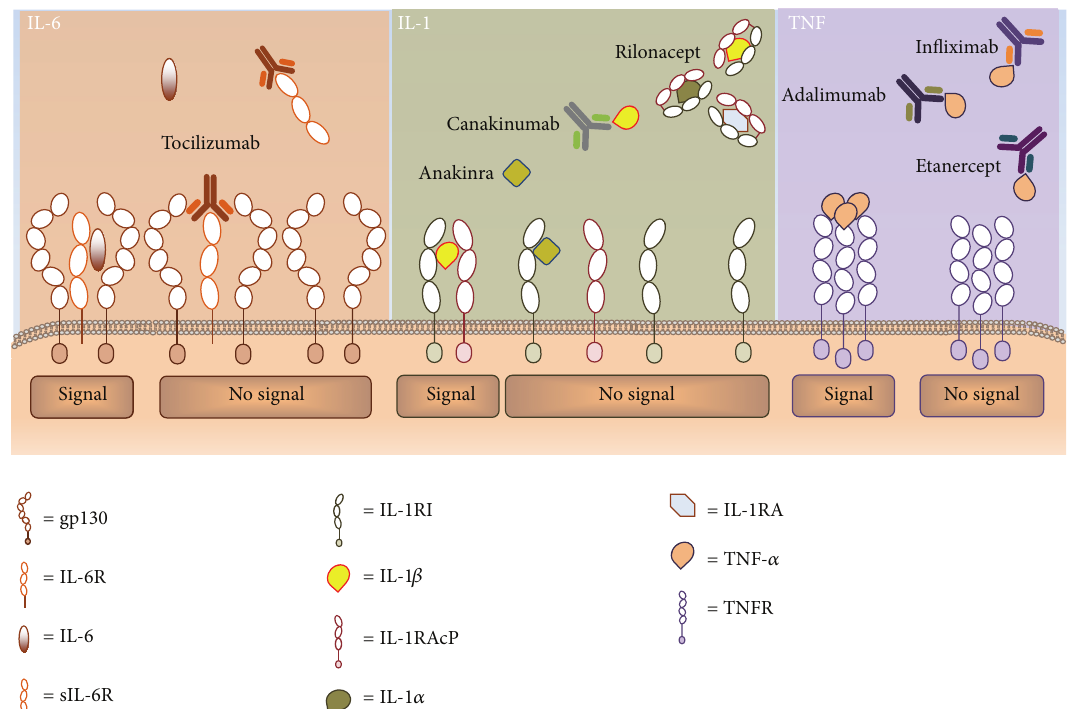
Figure 1: Mechanisms of IL-1, IL-6, and TNF- 𝛼 targeted therapies. Binding of IL-6 to the IL-6 receptor complex, involving IL-6 receptor (IL- 6R) and glycoprotein 130 (gp130), leads to activation of IL-6 signal transduction. Tocilizumab, a recombinant humanized anti-IL-6 receptor antibody, inhibits the binding of IL-6 to IL-6R or soluble IL-6R (sIL-6R), thus blocking IL-6 inflammatory response. Binding of IL-1 𝛽 to the IL-1 receptor type I (IL-1RI) promotes a receptor complex formation with the IL-1 receptor accessory protein (IL-1RAcP), that results in signal transduction activation. IL-1-targeted therapy includes anakinra (IL-1R receptor antagonist), canakinumab (anti-IL-1 𝛽 IgG1 mAb), and rilonacept (soluble IL-1 receptor that binds IL-1 𝛽 , IL-1 𝛼 , and IL1RA). Adalimumab, infliximab, and etanercept are anti-TNF blockers. Adalimumab is a fully human monoclonal anti-TNF antibody. Infliximab is a mouse/human chimeric monoclonal anti-TNF antibody. Etanercept is a dimeric fusion protein of TNFR2 (p75) linked with the Fc region of human IgG 1